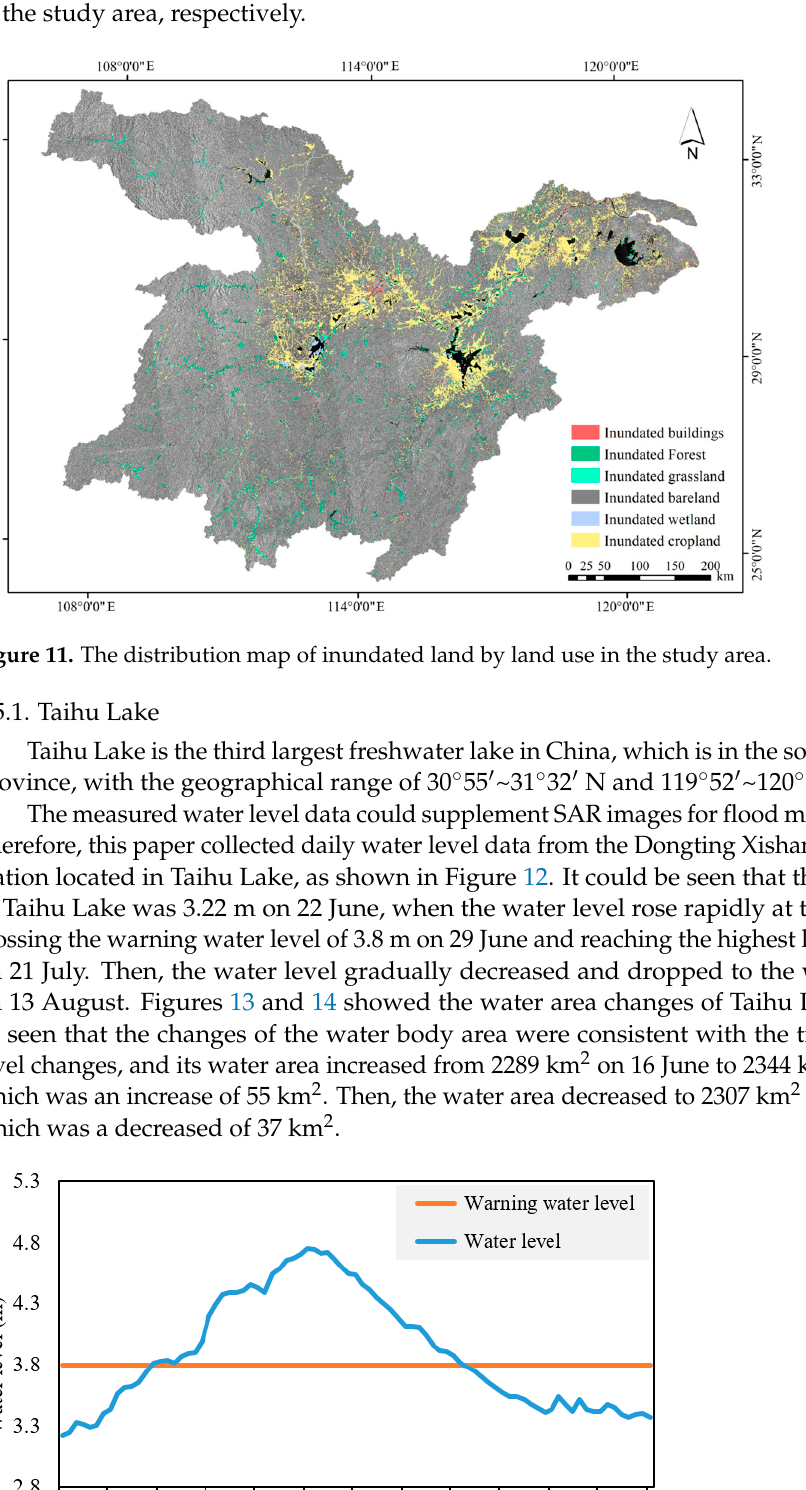
Table 6. The statistics of inundated land by land use in the MLB.